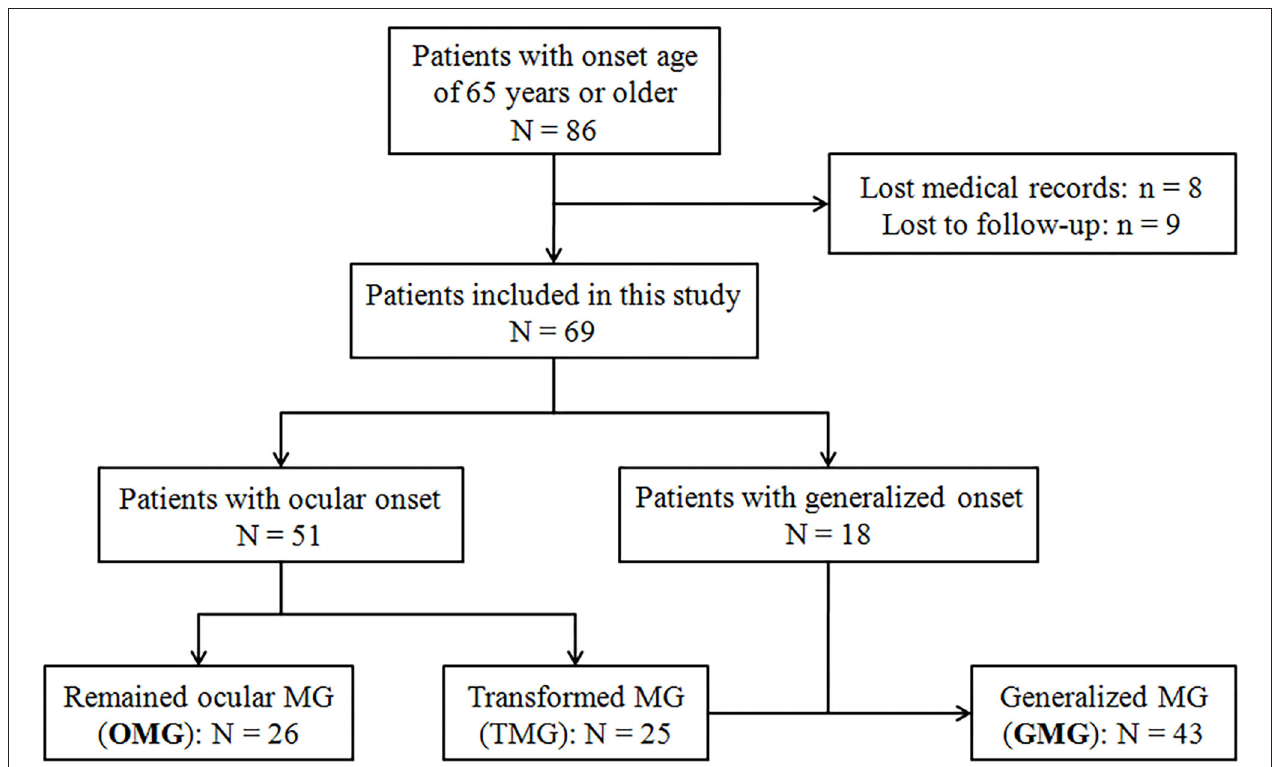
FIGURE 1 | Flowchart of the enrollment of the patient with v-LOMG in this